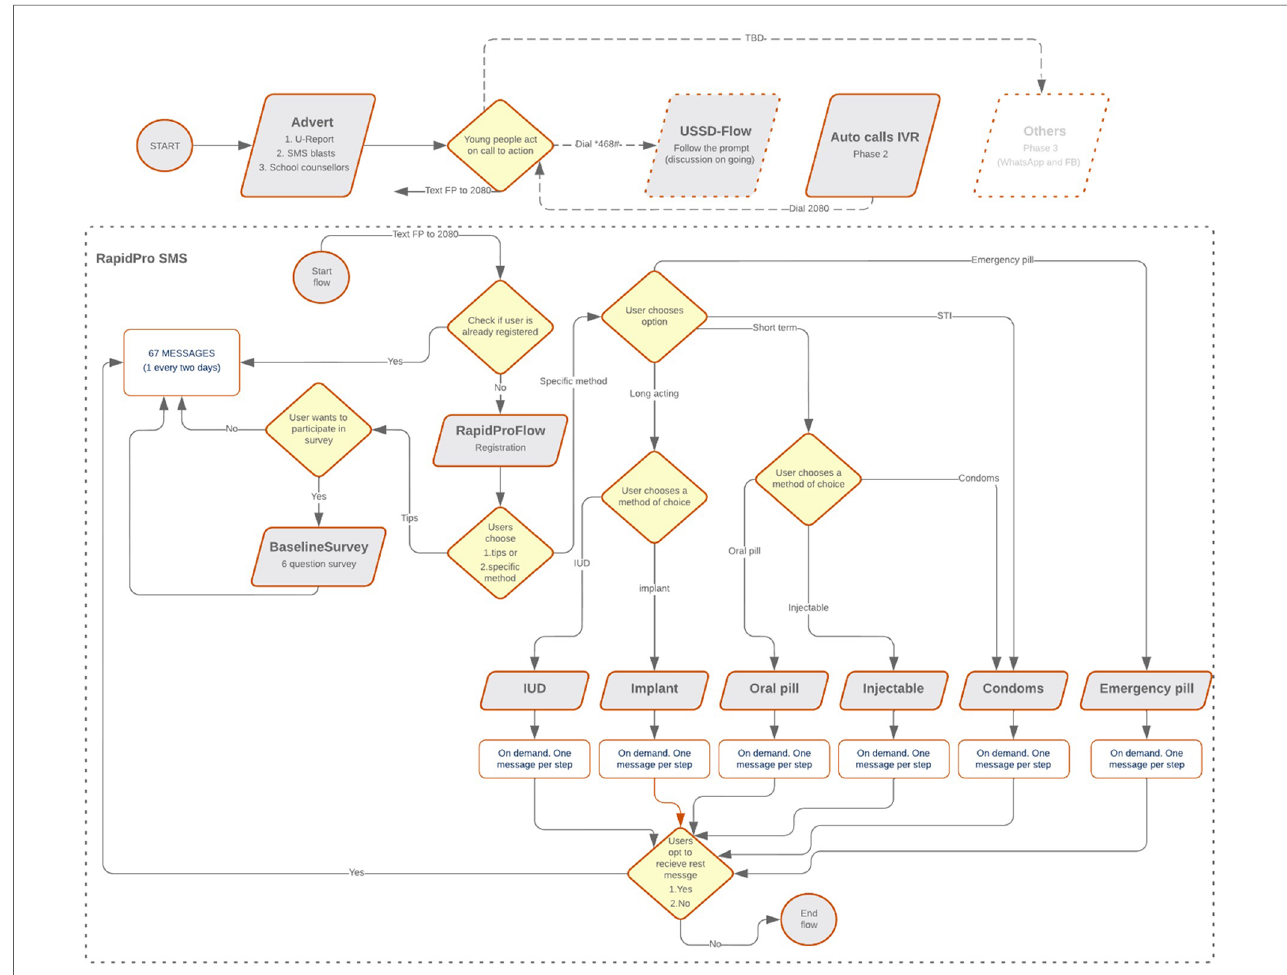
FIGURE 4 Work fl ow coded into RapidPro for automated and personalized SMS messaging. SMS, short message